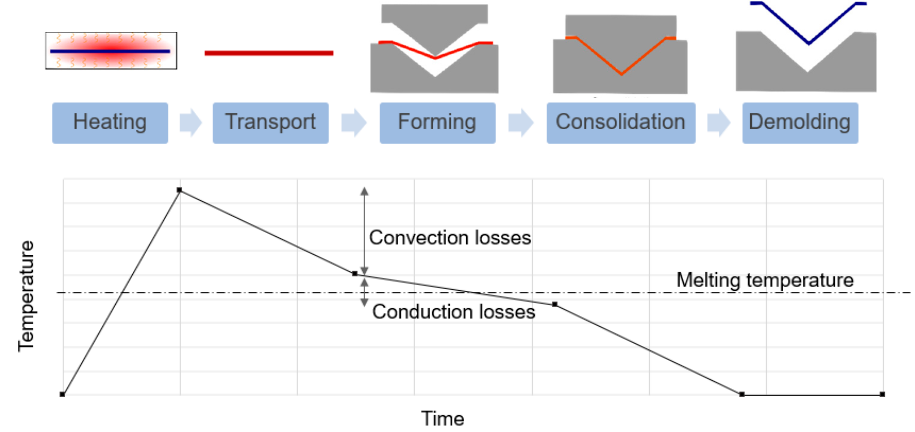
Figure 1. Principal steps of the thermoplastic thermoforming process.